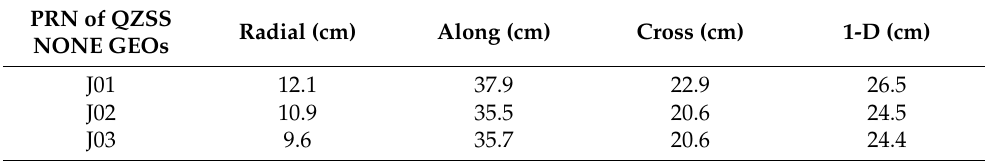
Table 8. Mean RMS value of QZSS NONE GEO satellites in comparison with GFZ final